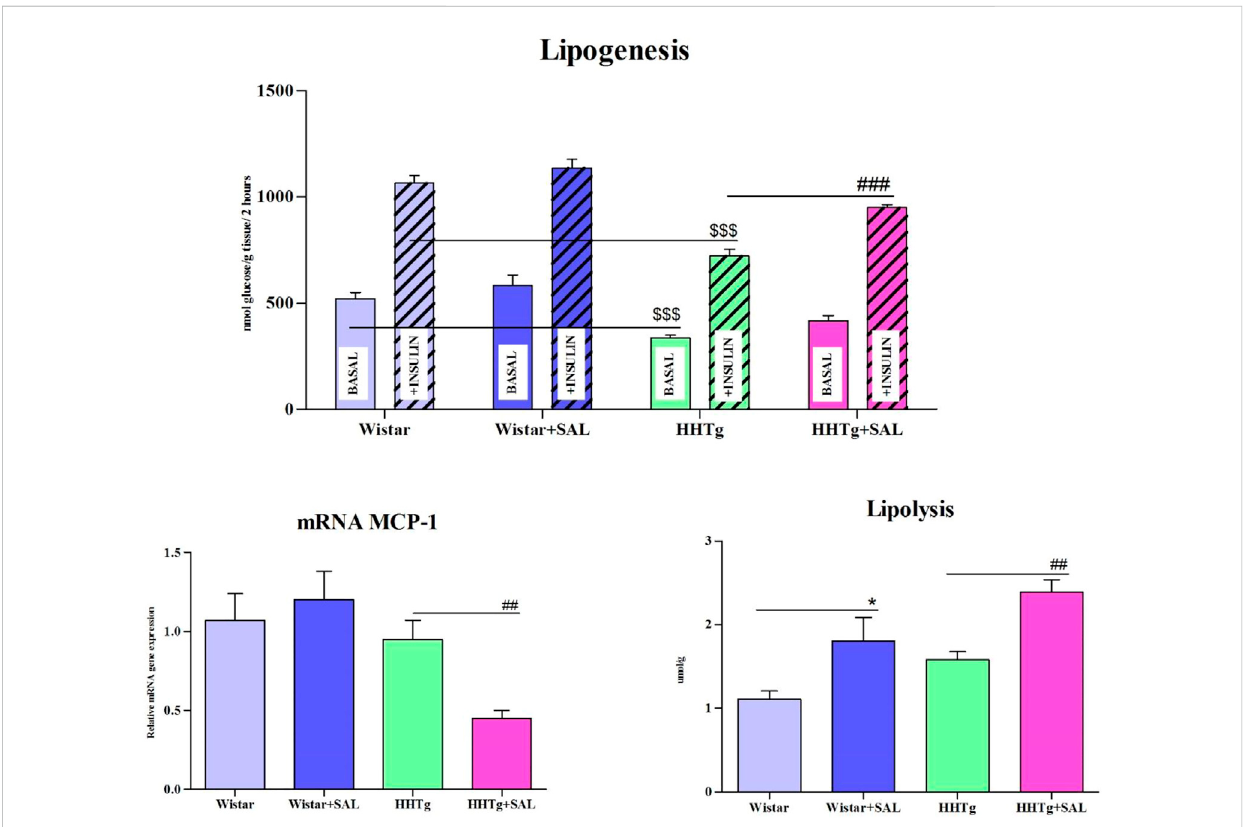
FIGURE 3 Effect of salsalate treatment on metabolic activity of epididymal adipose tissue. Basal and insulin-stimulated 14 C-U glucose incorporation into lipids in epididymal adipose tissue (lipogenesis), lipolysis and relative mRNA expression of MCP1 in Wistar control and hereditary hypertriglyceridemic (HHTg) rats.Valuesareexpressedasmean±SEM; n =8;*denotessigni fi cancere fl ectingtheeffectofWistarvs.Wistar+SAL, # denotessigni fi cancere fl ectingthe effect of HHTg vs. HHTg + SAL, $ denotes signi fi cance re fl ecting the effect of Wistar vs. HHTg; * p < 0.05; ## p ˂ 0.01, ### p ˂ 0.001; $$$ p ˂